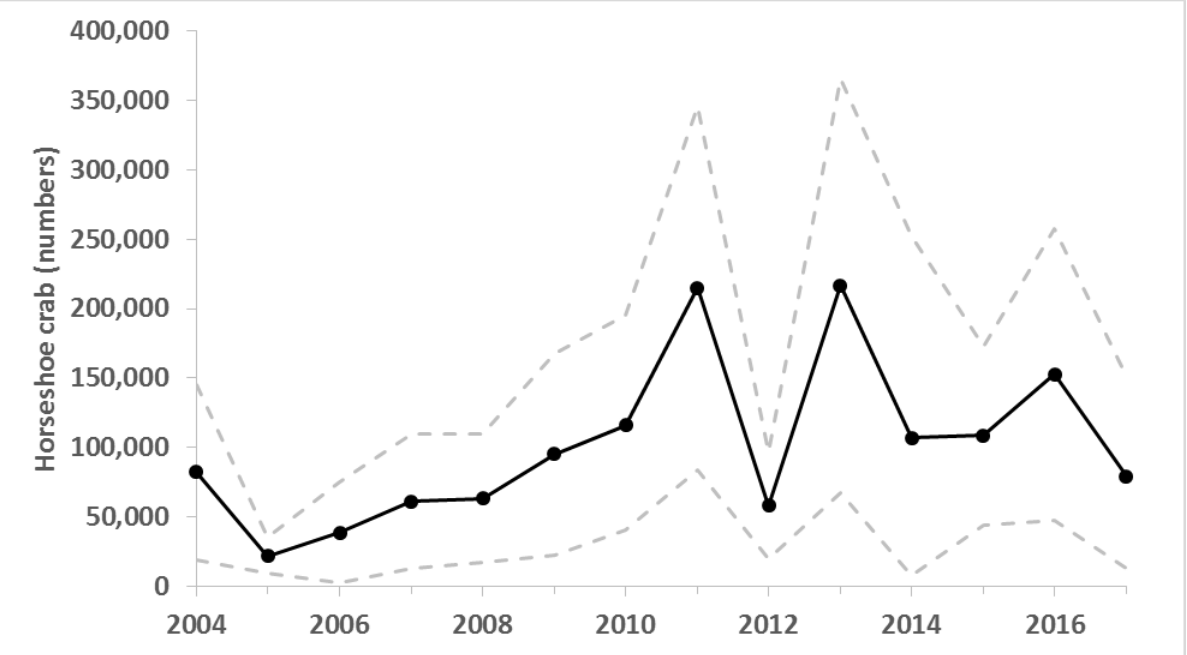
Figure 20. Number of dead discarded horseshoe crabs in the Delaware Bay region, 2004- 2017, from gillnets, trawls, and dredges with 95% confidence intervals.